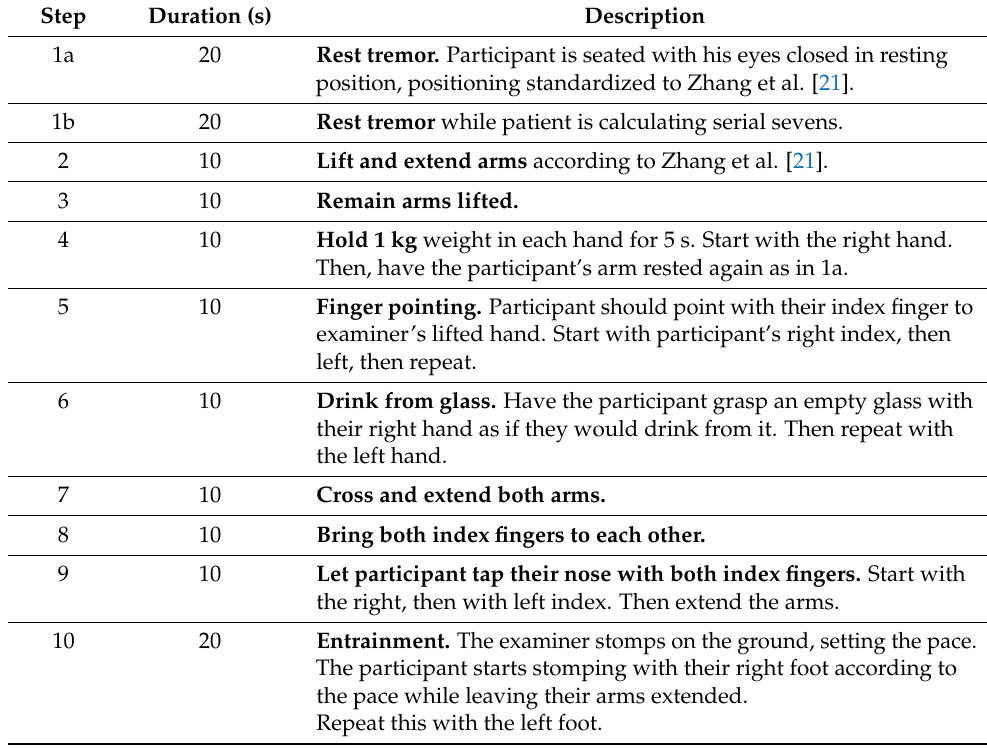
Table 2. Smartwatch-based examination